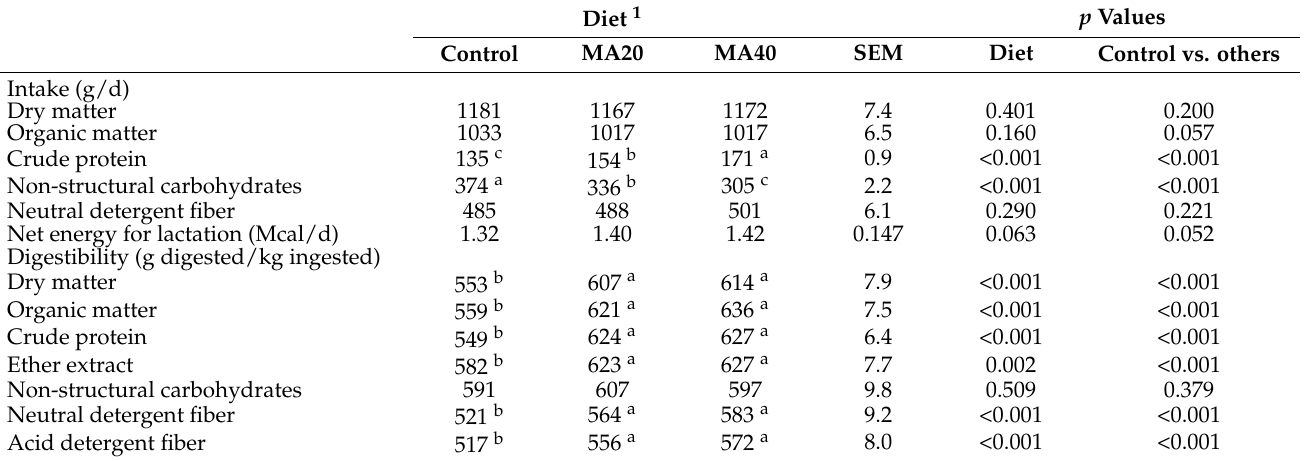
Table 2. Nutrient intake and digestibility of diets containing Moringa oleifera and Chlorella vulgaris microalgae fed to lactating Damascus goats ( n =